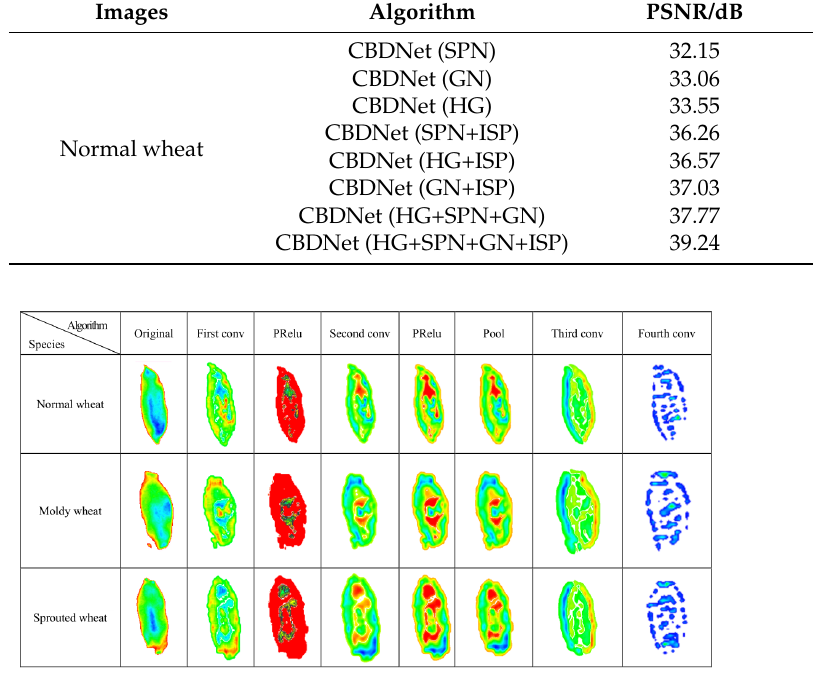
Figure 9. The feature maps for different layers.